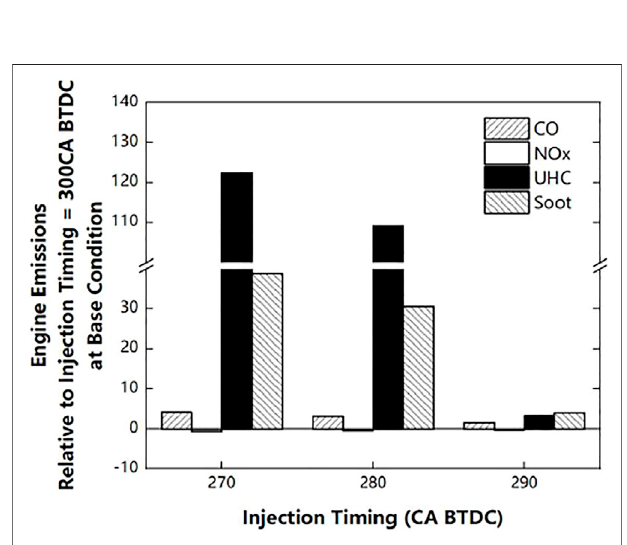
FIGURE 8 | Equivalence ratio and velocity fi eld at cylinder symmetry when sparked at different injection timings.